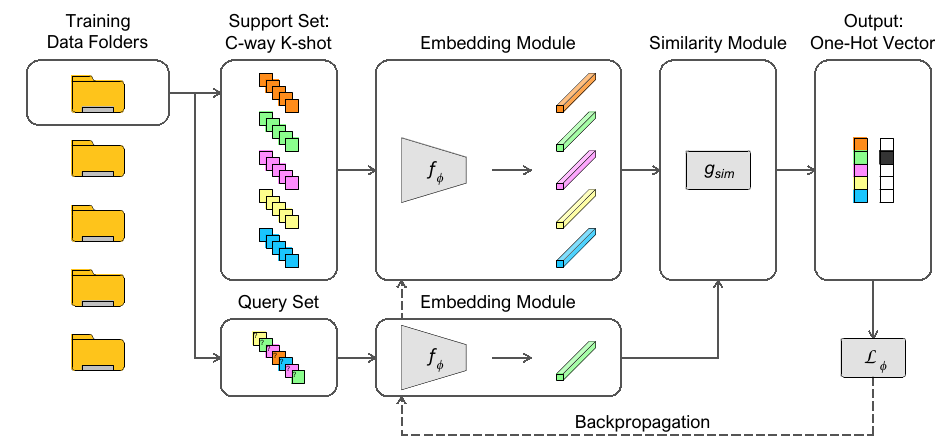
Figure 1. Episodic training procedure ( 5-way 5-shot example) of few-shot metric